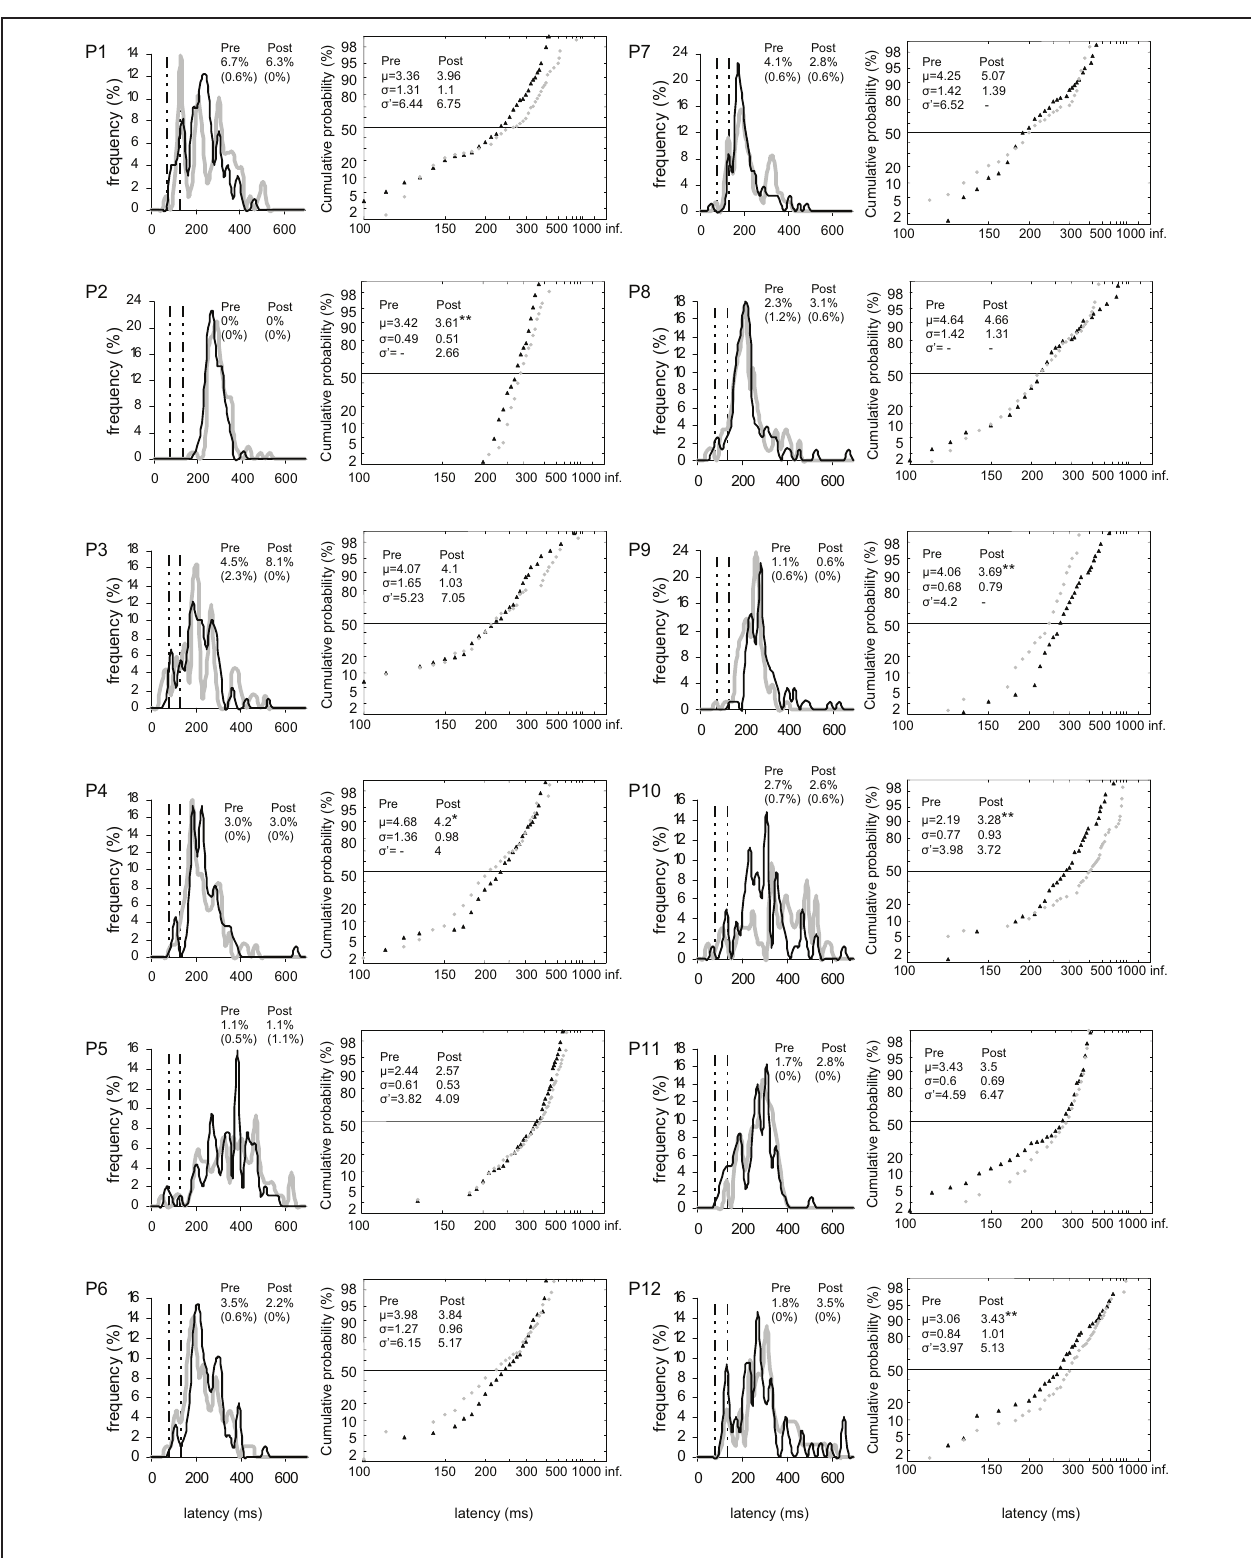
FIGURE 5 | Results for every participant in Pre-test (gray) and Post-test (black) periods for right target. (Columns 1, 3) Histograms of Frequency (in %) as a function of Latency (in ms) for saccades between 0 and 999ms in valid direction, and rates of express (Exp) and of anticipatory (Ant) saccades.